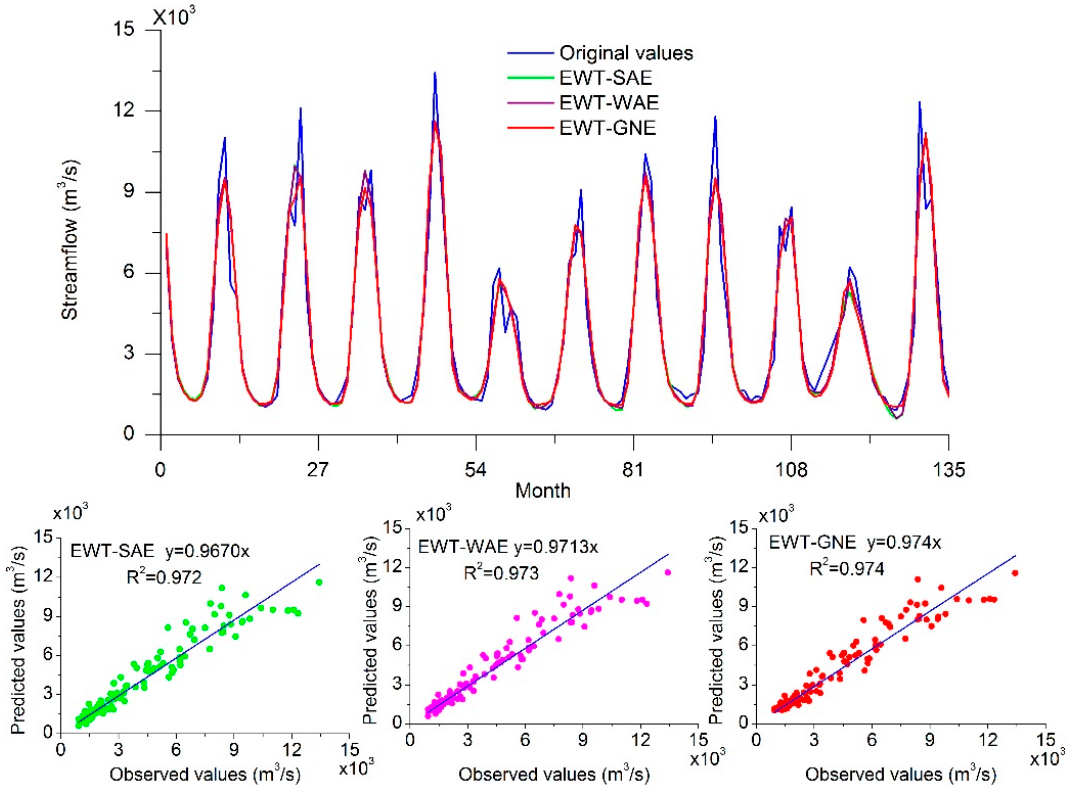
Figure 7. Forecasting results of the simple averaging ensemble (SAE), weighted averaging ensemble (WAE) and GRNN-based ensemble (GNE) models with EWT in the validation stage.